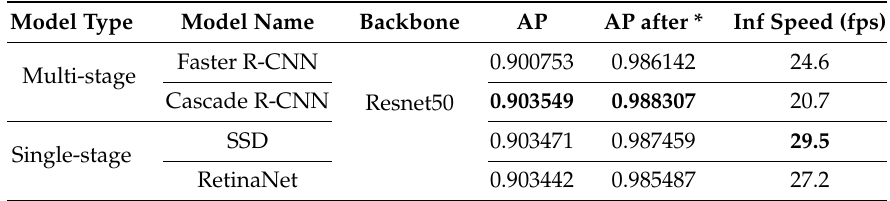
Table 1. A comparison of average precision (AP) and inference speed of four different models. The bold numbers denote the optimal values in each column.